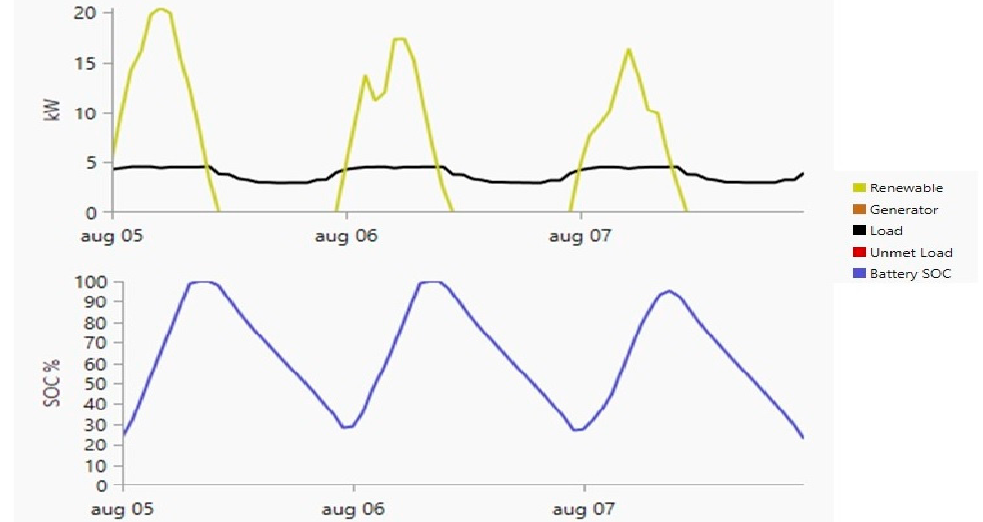
Figure 16. System 2: HOMER grid configuration.